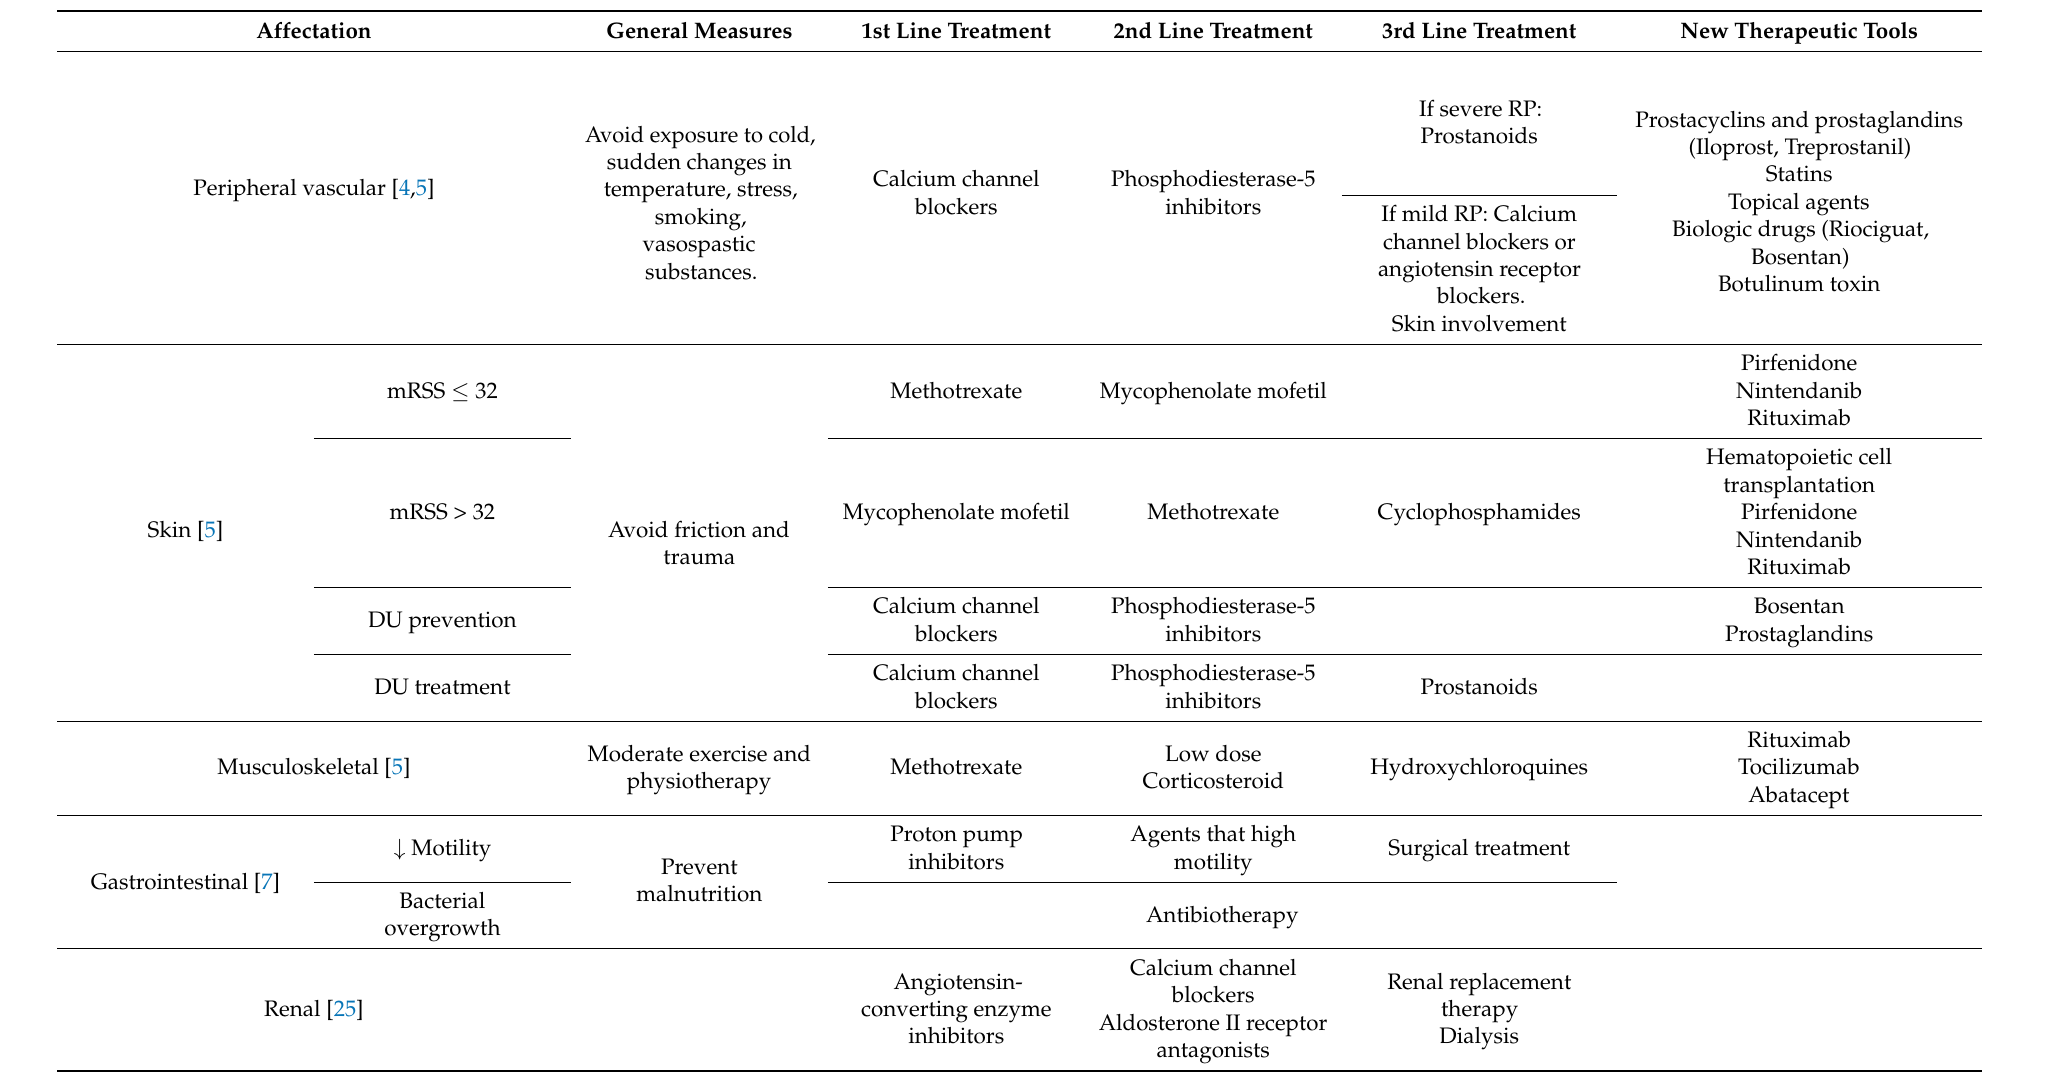
Table 3. Therapeutic strategies used in the treatment of systemic sclerosis